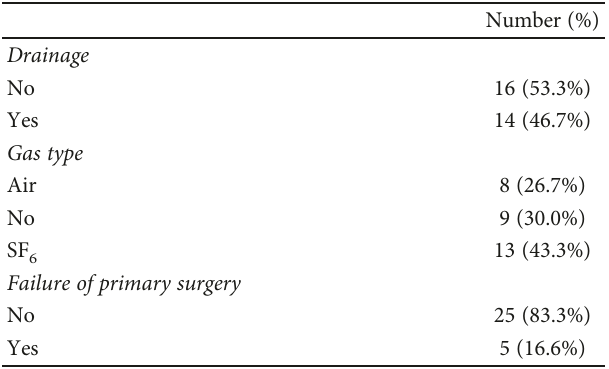
Table 2: Distribution of the studied cases according to operative details.